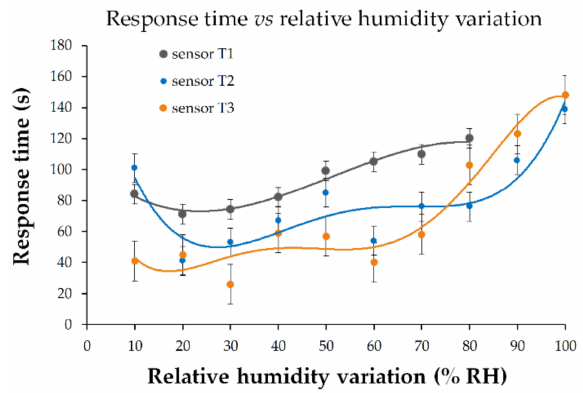
Figure 15. Response time vs. relative humidity (%) for sensor T1, sensor T2, and sensor